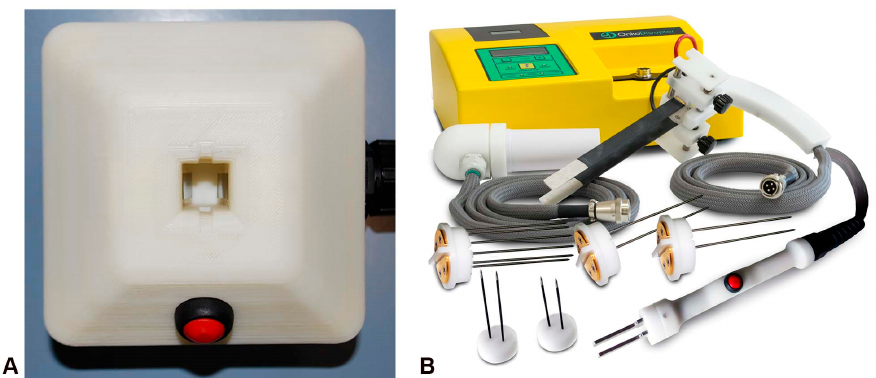
Figure 5. The main types of devices: ( A ) device for in vitro experiments; ( B ) pulse generator and needle electrodes for clinical use.